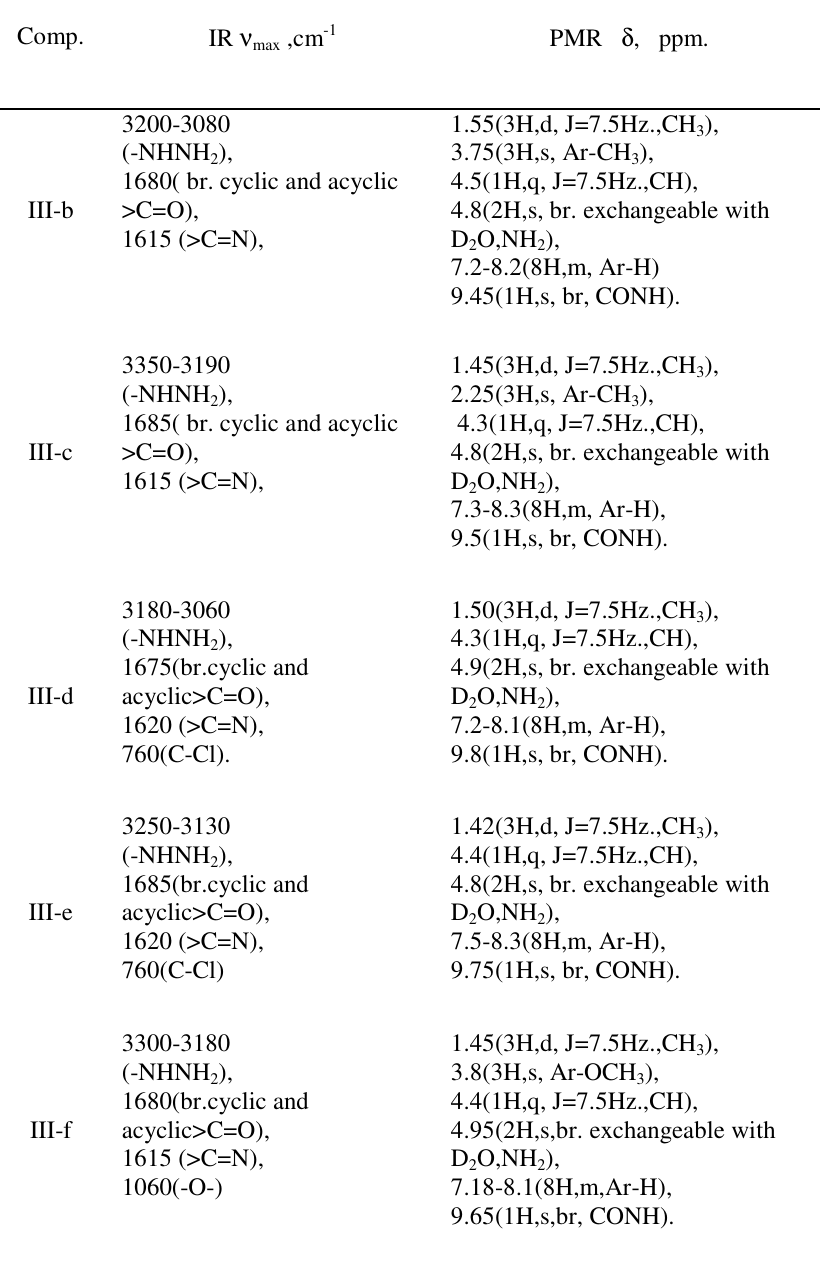
Table 4 . Spectral Characteristics of the compounds [III-(b-g)]